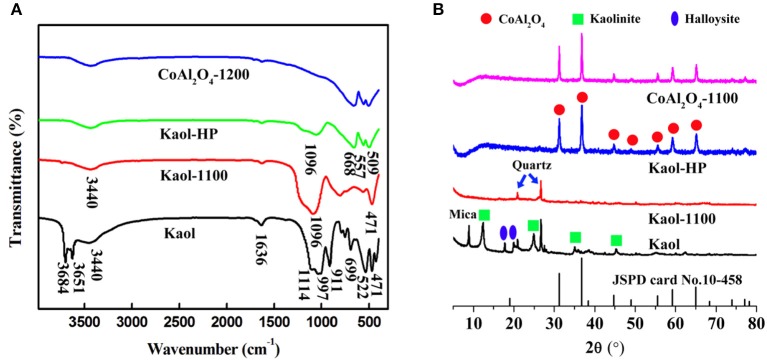
(A) FTIR spectra and (B) XRD patterns of the raw Kaol, Kaol-1100, Kaol-HP, and CoAl2O4-1200, respectively.